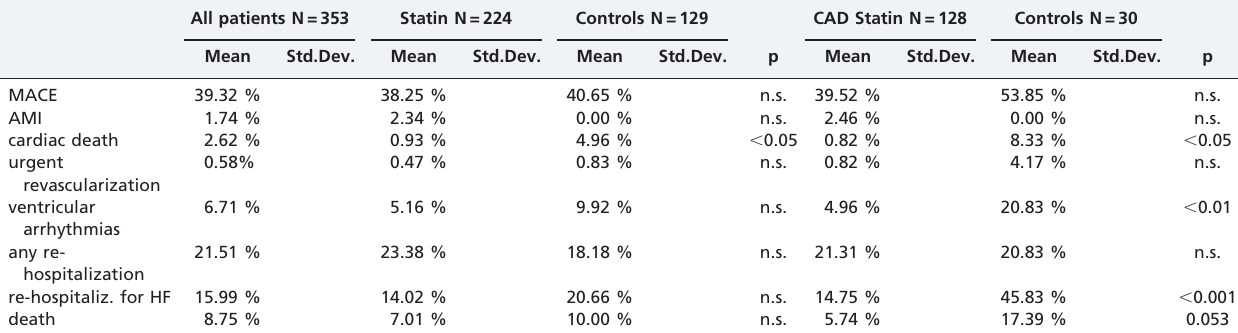
Table II - Clinical